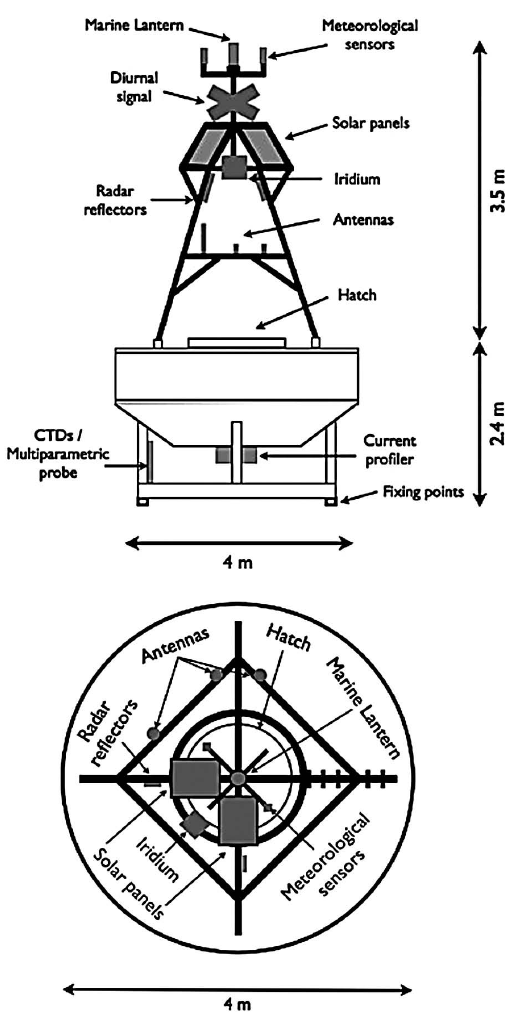
f ig . 4. – Frontal (top) and upper (bottom) views of an oceanic buoy and the external elements installed on it. The structure has two parts: the turret (black) and the hull